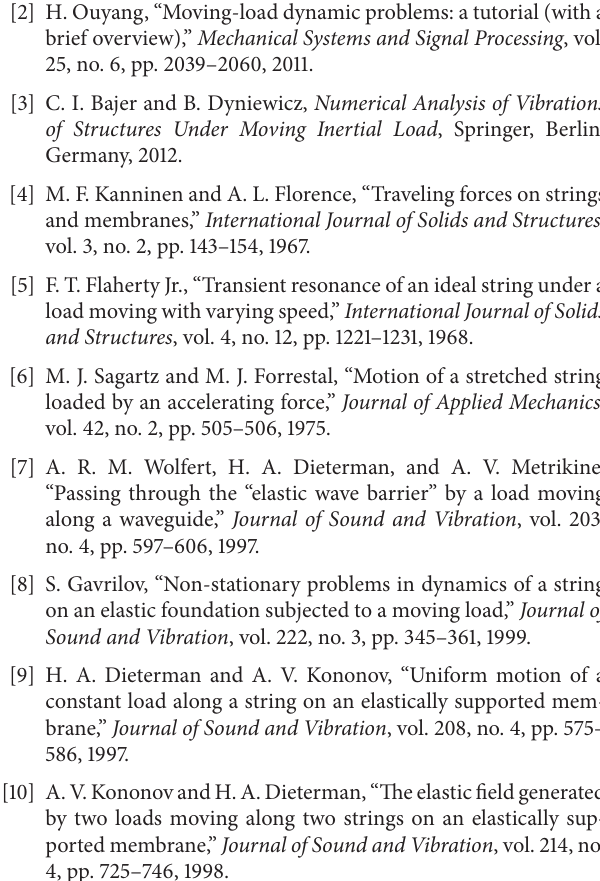
mass moves at sonic velocity, the contact force between the mass and the string is 𝑝(𝑡) = 𝑚𝑔[ exp (−2𝜌𝑐𝑡/𝑚) − 1] and the displacement of the contact point is